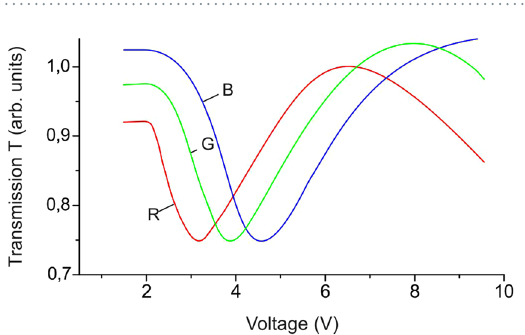
Figure 7. White light transmission T of the LC layer vs. electric voltage U . The light was transmitted through a cell formed on the basis of sample 15 using red (R), green (G), and blue (B) filters in crossed